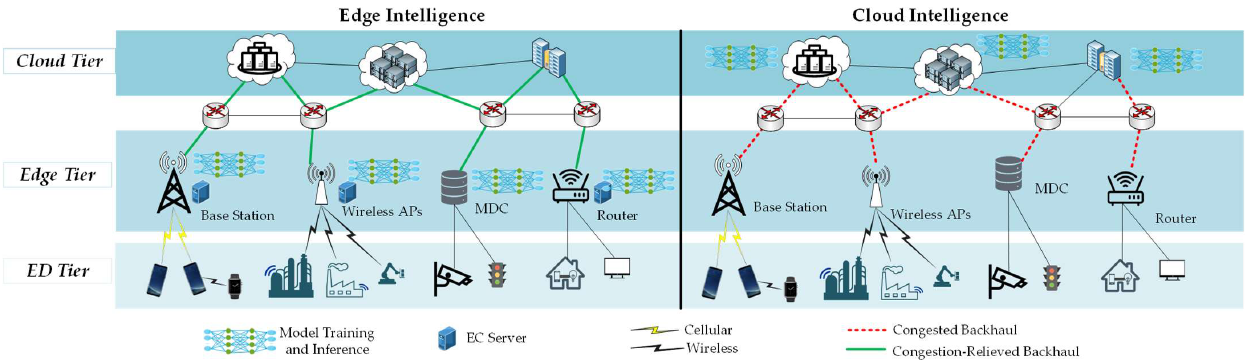
Figure 1. Cloud and edge intelligence.